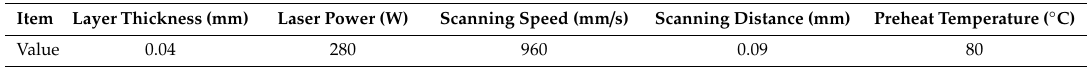
Table 2. Selective laser melting (SLM) building process parameter.